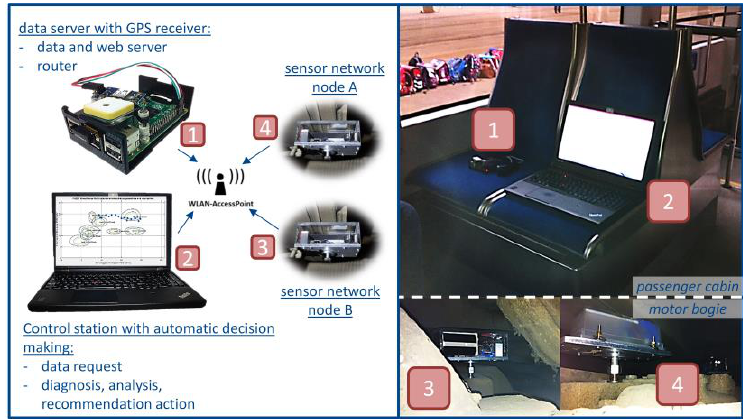
Figure 8. Developed wireless sensor network on the motor bogie of a tram.